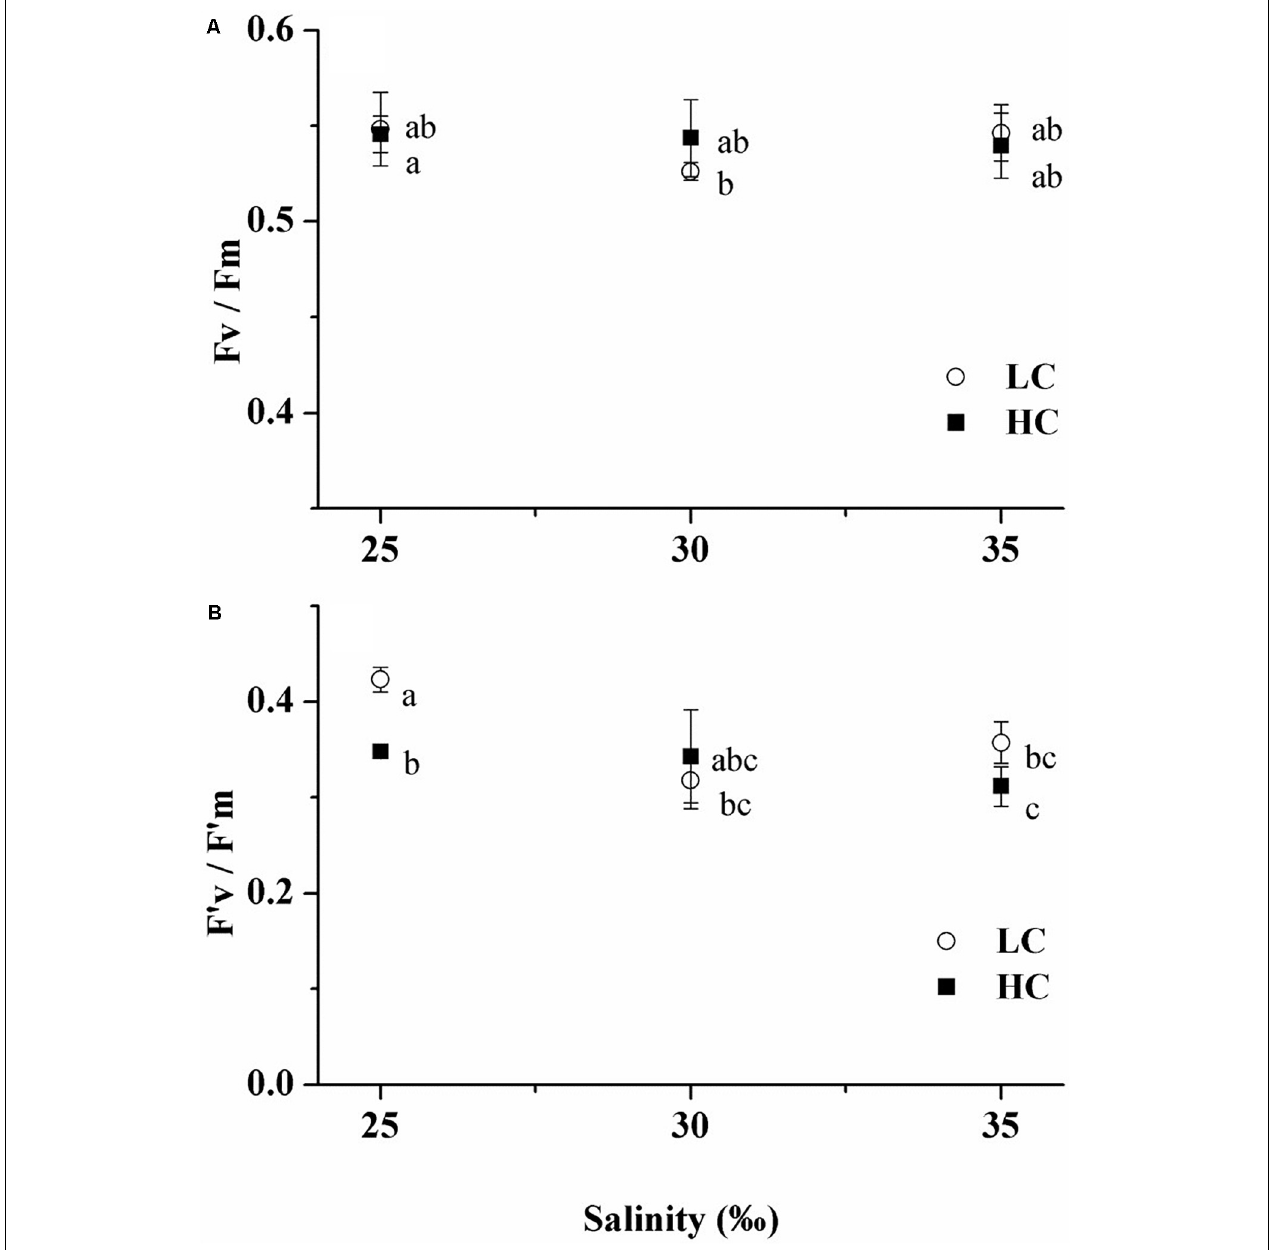
FIGURE 3 | Maximum (A) and effective photochemical quantum yields (B) of Emiliania huxleyi at three salinities (LC, open circles; HC, solid squares). Values are means ± SD of triplicate cultures. Symbols with different lowercase letters indicate significant differences ( p < 0.05) among different treatments.